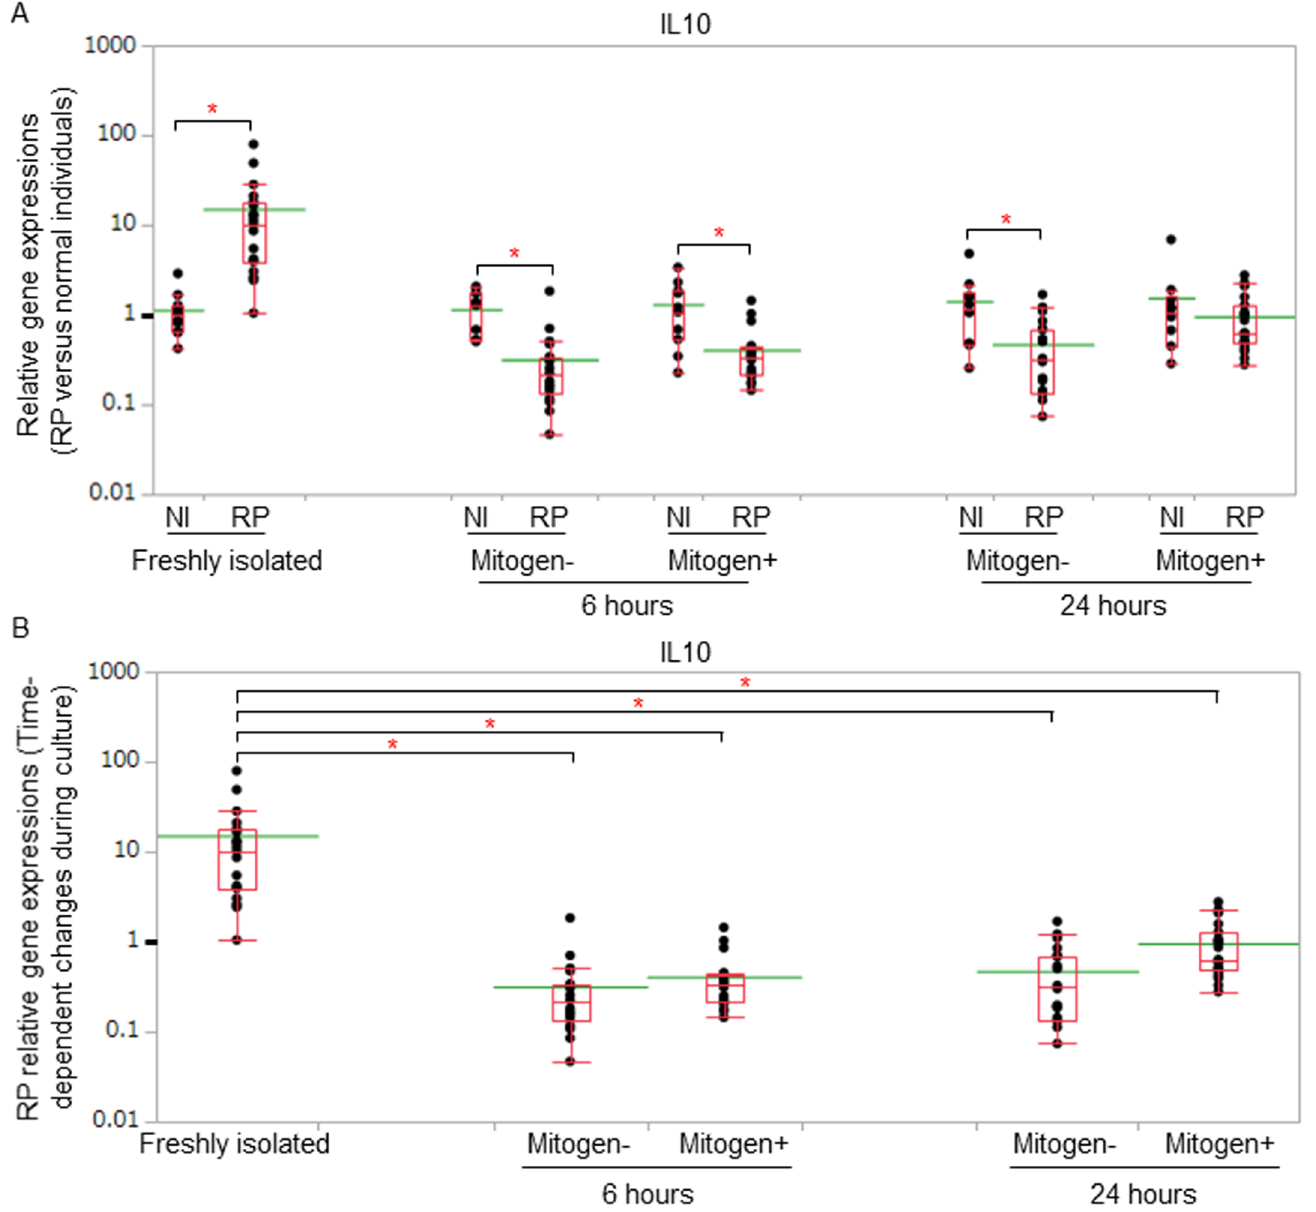
Fig 3. IL10 gene expressions on PBMC of RP patients. (A) IL10 gene expressions of RP PBMC compared with those of normal PBMC. We measured IL10 gene expressions of freshly isolated, 6-hour-cultured, and 24-hour-cultured PBMC in RP patients (RP) and normal individuals (NI). Gene expressions of RP patients were estimated by the ΔΔ Ctmethod, followed by normalization of the titers relative to 2 - ΔΔ Ct of normal individuals. The gene expression levels of normal individuals were defined as 1.000. IL10 gene expressions of freshly isolated PBMC were significantly higher in RP patients than those in normal individuals. IL10 gene expressions were significantly lower in RP patients than those of normal individuals 6 hours after the initiation of the cell culture, regardless of the presence and absence of mitogen stimulation. (B) Time-dependent changes of IL10 gene expressions of RP PBMC. We compared the gene expression data of the freshly isolated PBMC with those of cultured PBMC in patients with RP. IL10 gene expressions decreased significantly regardless of the presence and absence of mitogen stimulation in RP patients after the initiation of the cell culture. Relative gene expressions of RP patients against those of normal individuals were displayed with dot plots. A box-plot and a mean level (green line) of each group of RP patients and normal individuals were